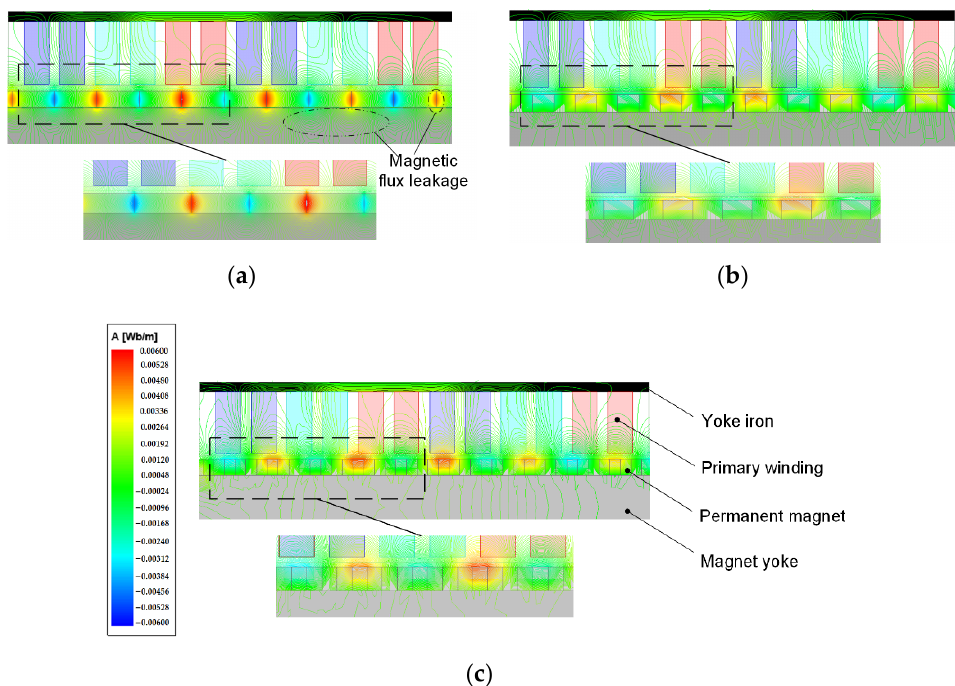
Figure 5. Magnetic field distribution: ( a ) Electromagnetic actuator with radially magnetized sec- ondary; ( b ) Electromagnetic actuator with Halbach three-section magnetized secondary; ( c ) Electro- magnetic actuator with Halbach five-section magnetized